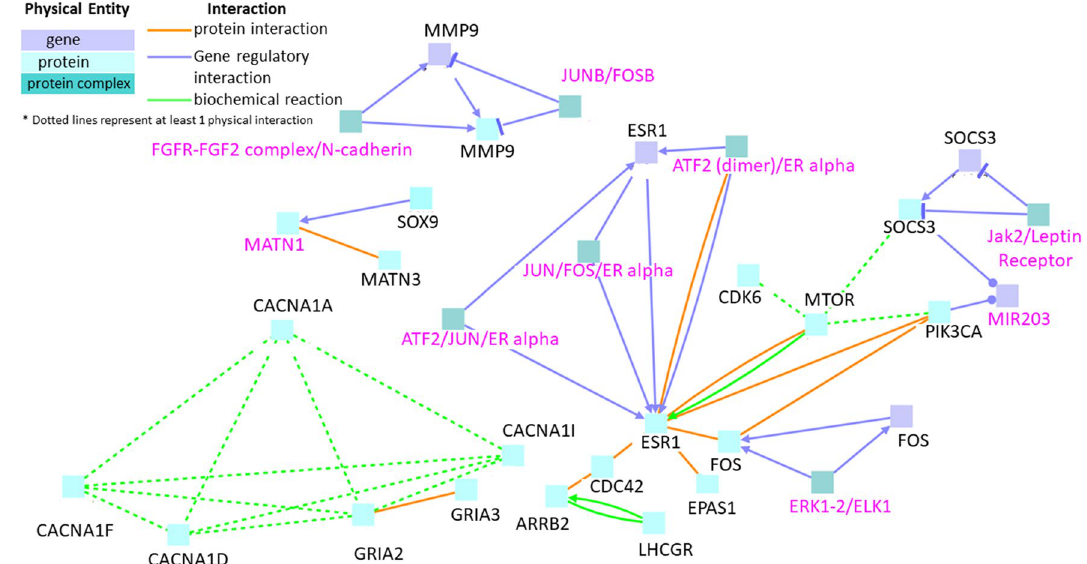
Figure 3. Interactions between genes that are exclusively downregulated in neurotoxicity. Black labels denote seed nodes and pink labels denote intermediate nodes. Each line represents an interaction. Dotted lines represent at least one physical interaction. Line ending with an arrow represents stimulation whereas line ending with a small blunt line represents